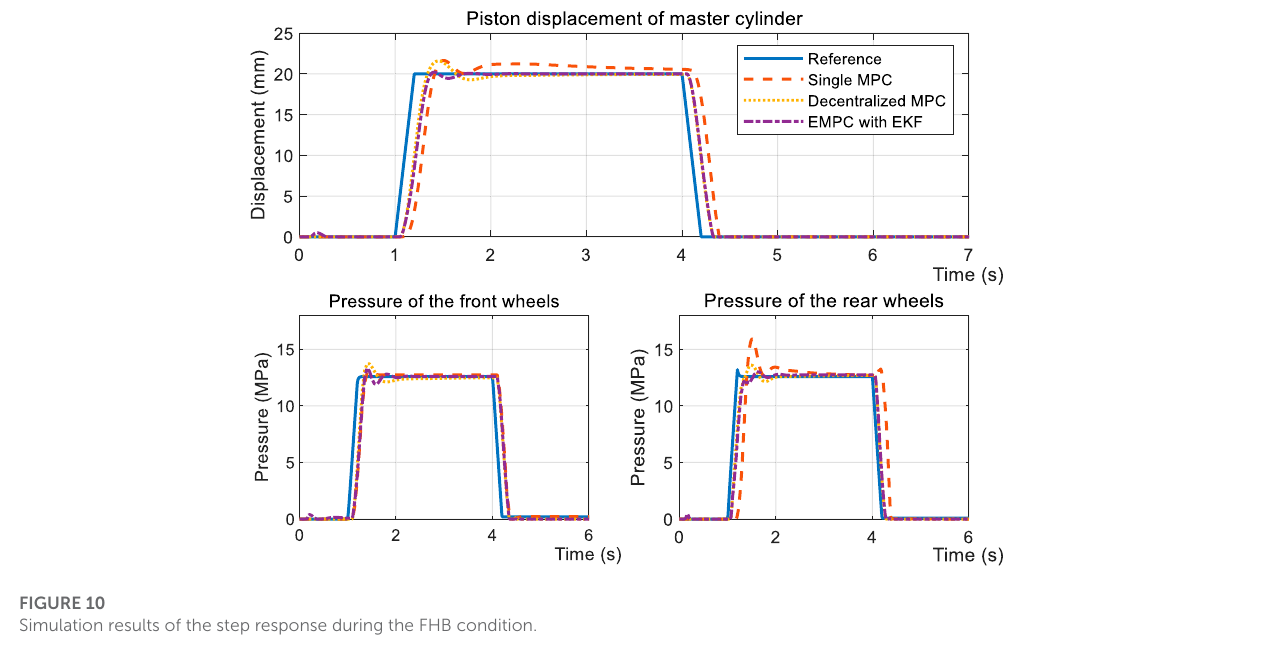
FIGURE 10 Simulation results of the step response during the FHB condition.